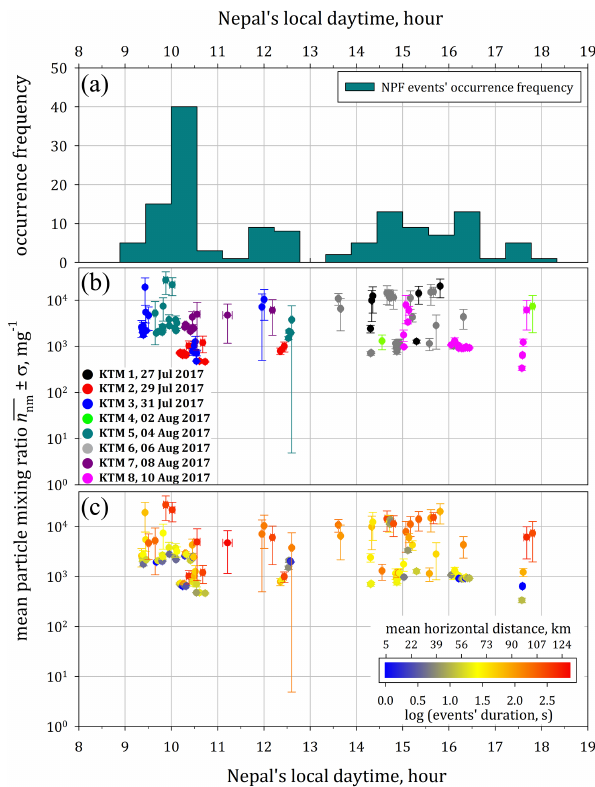
Figure 5. (a) Diurnal variation in the occurrence frequency of NPF events. (b) The diurnal distribution of NPF events’ mean particle mixing ratio n nm with standard deviation σ , coloured by flight date, and (c) in colours of the (logarithmic) duration of the re- spective event. Note that the mean horizontal distance is derived from the event duration based on a mean flight speed of 154ms − 1 ( σ =± 39ms − 1 ; variable flight attitude remains unconsidered) and is understood as equivalent horizontal extension of an NPF event.